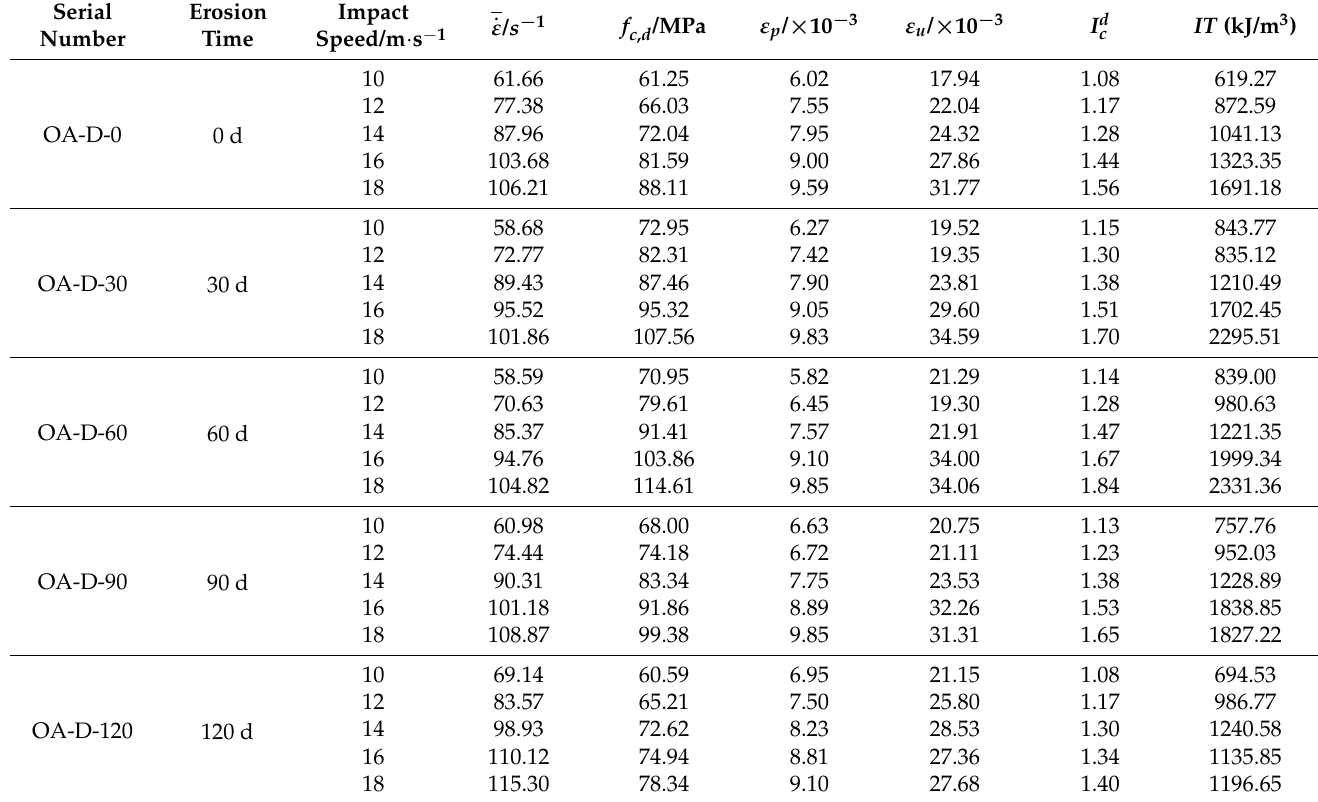
Table 1. Uniaxial dynamic compression test results of concrete test pieces after sulfate attack.